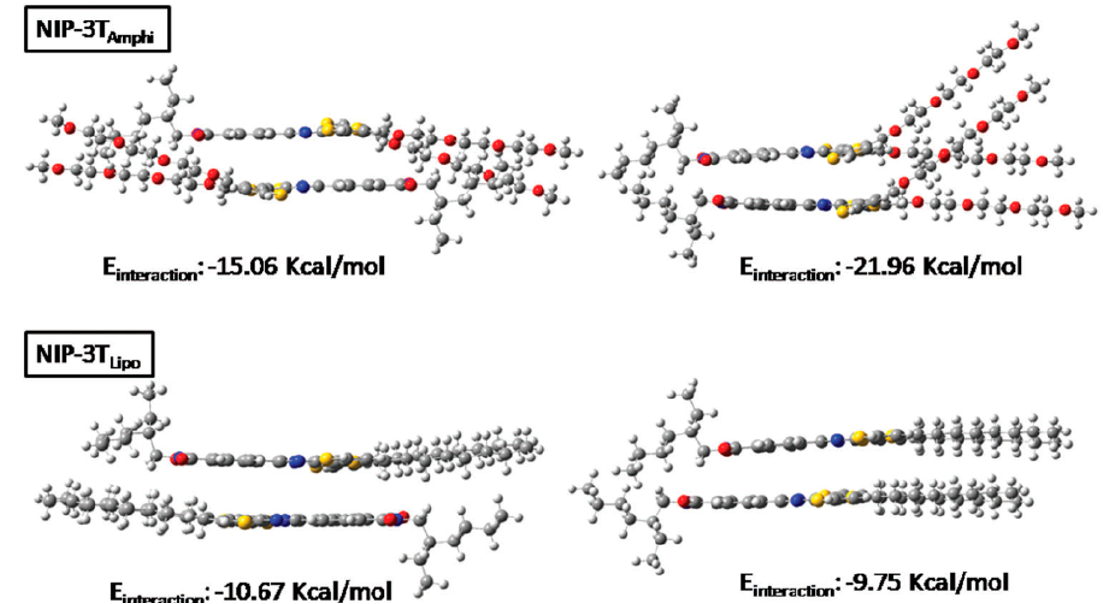
Figure 16. CAM-B3LYP/6-31G** estimated dimers (left: antiparallel configuration (AP) and right: parallel configuration (P)) for NIP-3T amphi and NIP-3T lipo . Reproduced from with permission from the PCCP Owner Societies [30].